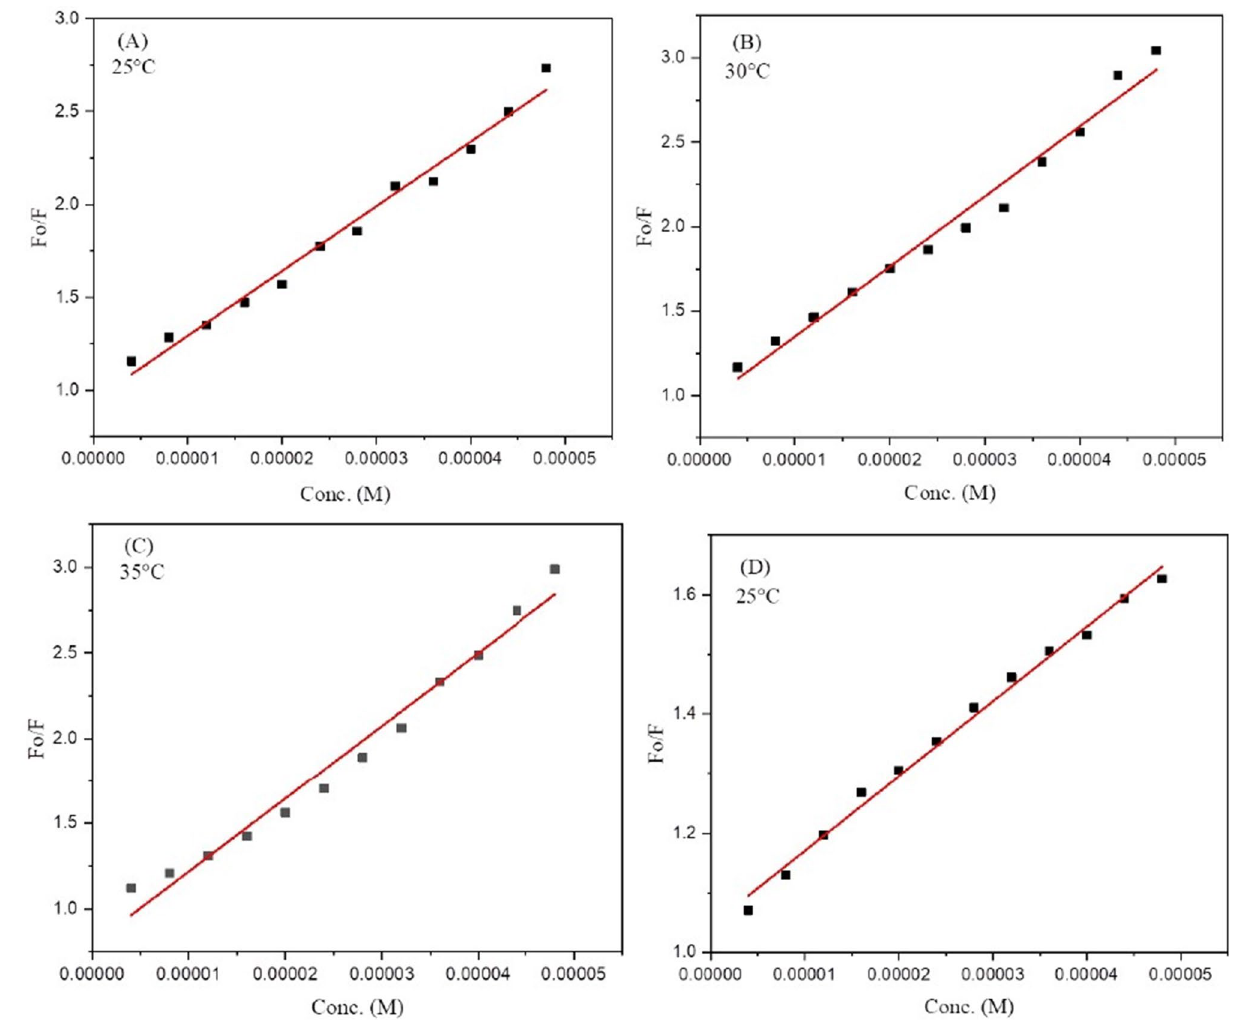
Figure 11. Stern–Volmer plots for the DNA/BSA- 4g complex system ( A ) BSA-4g complex at 25 °C; ( B ) BSA-4g complex 30 °C; ( C ) BSA-4g complex at 35 °C; ( D ) DNA-4g complex at 25